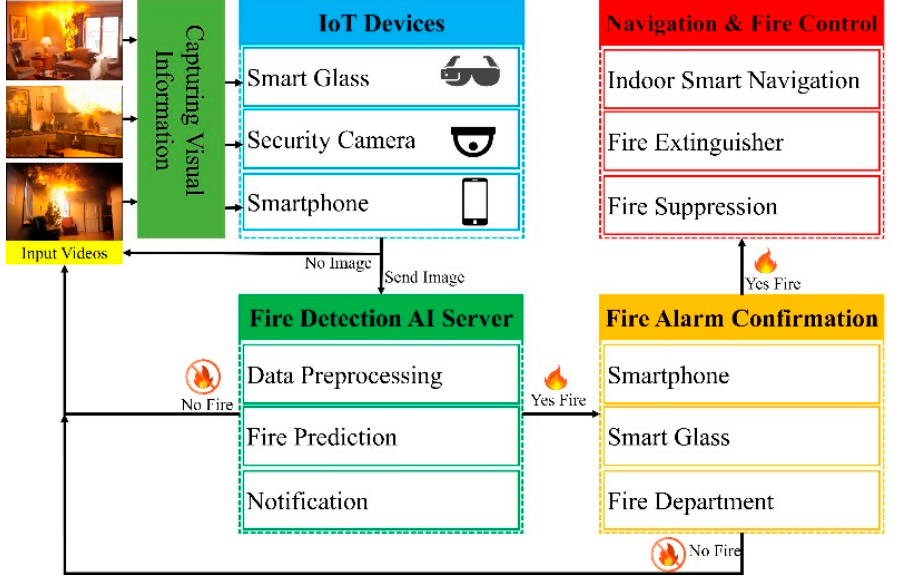
Figure 1. Overall flowchart of the system.